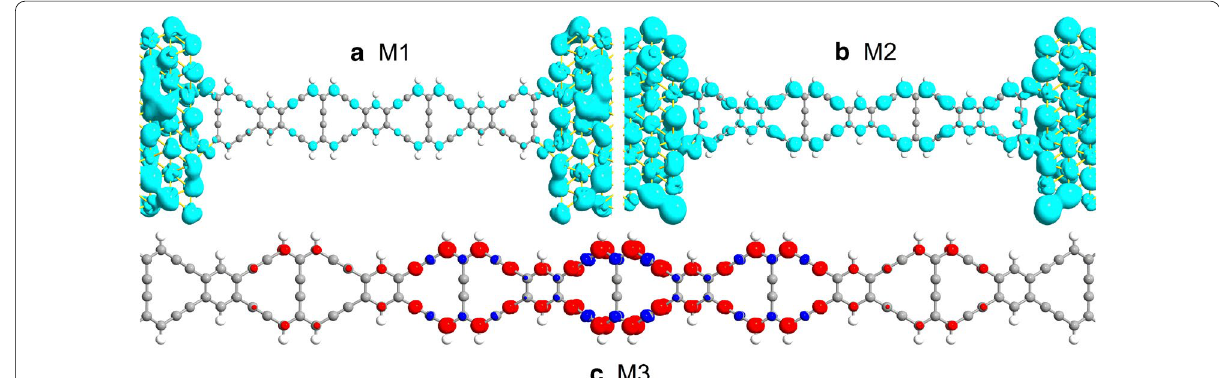
Fig. 4 (Color online) The DLDOS at the energy of 0.02 eV has been displayed as a M1 and b M2, respectively. The isovalue is taken as − 0.01 Å − 3 eV − 1 . c The spin density isosurface of M3 has also exhibited, where the red and blue colors stand for the spin-up and -down components, · respectively. The isovalue is taken as 0.015 Å − 3